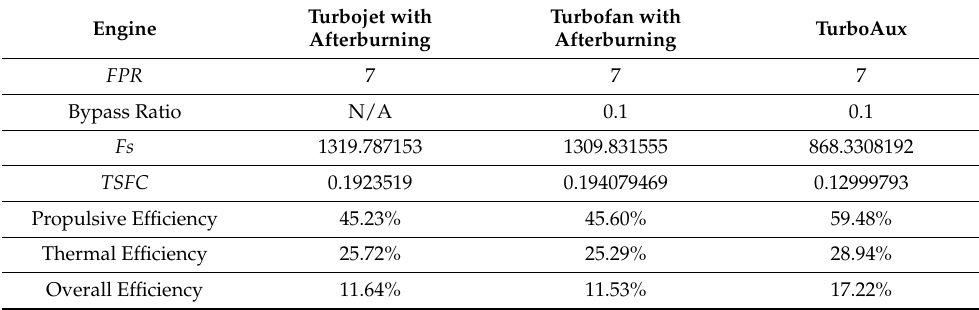
Table 6. Performance Results of Turbojet, Turbofan, and TurboAux at BPR of 0.1.